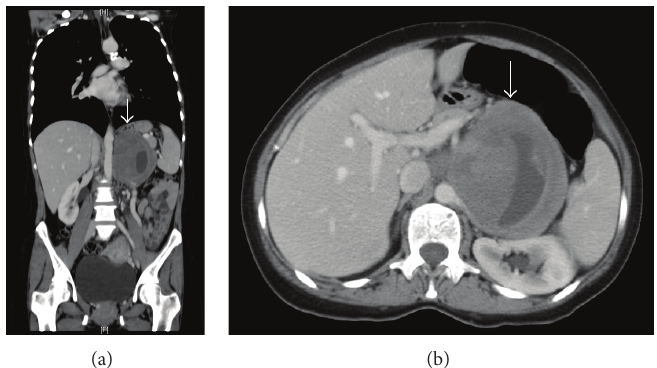
Figure 1: Coronal (a) and transverse (b) contrast-enhanced computed tomography (CT) scan showed a 9.2 × 9.5 × 11.5 cm, huge, and well-defined left suprarenal mass (arrow) arising either from adrenal gland, pancreas, or retroperitoneum. The mass demonstrated mild heterogeneous enhancement with central cystic/necrotic area. No evidence of lymphadenopathy or regional/distant metastasis was identified.